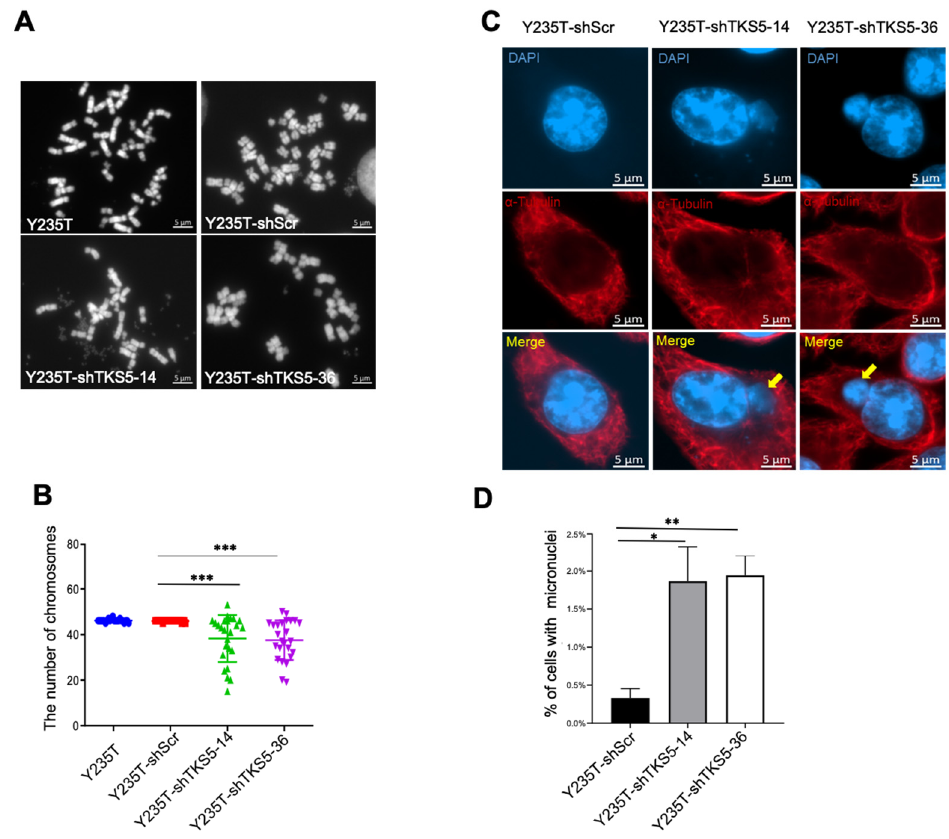
Figure 4. Decreased TKS5 expression results in augmented aneuploidy and increased micronuclei generation. ( A ) Representative images of metaphase spreads of Y235T parental cells, Y235T cells with the control shRNA (Y235T-shScr) or Y235T cells with TKS5-specific shRNAs (Y235T-shTKS5-14 and Y235T-shTKS5-36). ( B ) Numbers of chromosomes deviating from normal karyotype in Y235T parental (n = 22), Y235T-shScr (n = 25) and TKS5-knockdown cells. Minor variations in euploid chromosome numbers (46 chromosomes) in Y235T control cells, likely due to experimental conditions. ( C ) Representative images of micronuclei in TKS5-knockdown Y235T cells. We stained the nuclei and micronuclei with DAPI; we stained the microtubules with an anti- α -tubulin-specific antibody. Yellow arrowheads indicate micronuclei. ( D ) Quantitation of micronuclei counting. Graph shows percentage of micronuclei in Y235T control scramble cells and Y235T-shTKS5. We took the pictures with a 63× objective lens. The results are from three independent experiments. We used Student’s t -test to analyse the statistical significance. Error bars represent mean +/ − SEM (* p < 0.05; ** p < 0.01; *** p < 0.001).